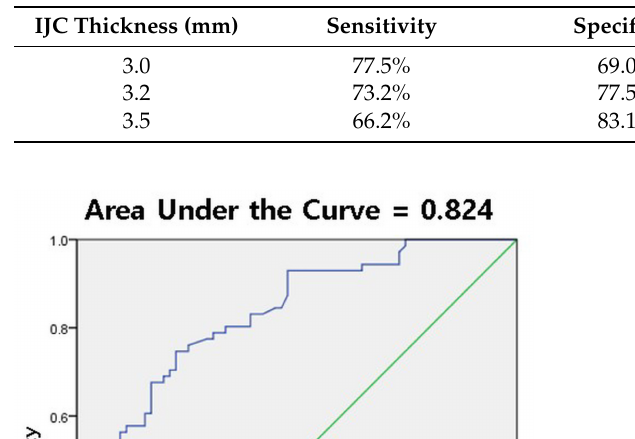
Table 3. Diagnostic accuracy according to cutoff value of inferior joint capsule (IJC) thickness on ultrasonography.